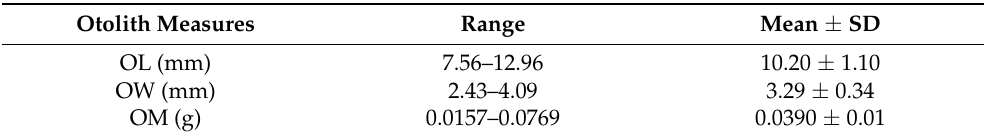
Table 2. Range of otolith measures (OL = otolith length, OW = otolith width, OM = otolith mass) and their mean values with standard deviation (SD) of the European barracuda, Sphyraena sphyraena , in the eastern Adriatic.